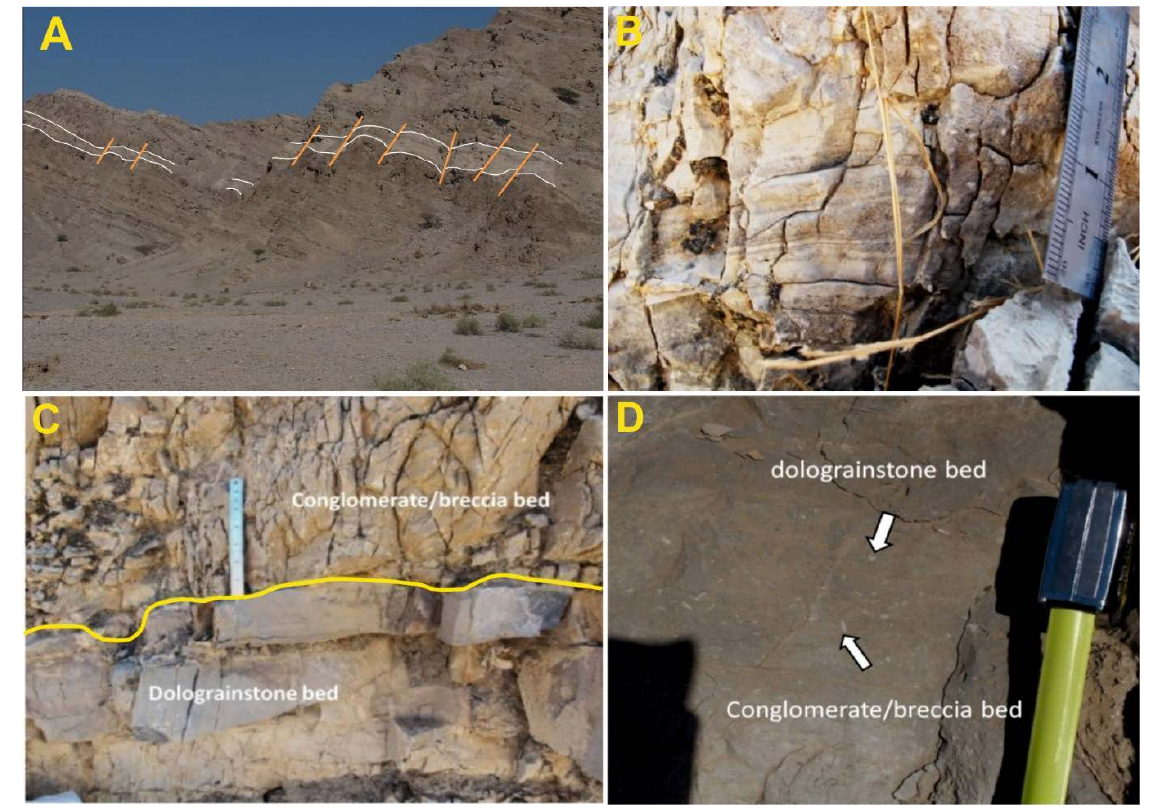
Figure 3. Field photographs showing: ( A ) The conglomerate/breccia beds are cut across by a series of normal faults, the conglomerate/breccia beds are shown by white lines, the faults are shown by orange lines. ( B ) Parallel lamination occurs at 14 cm above the basal contact in the conglomerate/breccia beds. ( C ) The contact (yellow line) between conglomerate/breccia and underlying massive dolostone bed. ( D ) The conglomerate/breccia beds have a gradational contact with overlying dolograinstone bed (arrows).